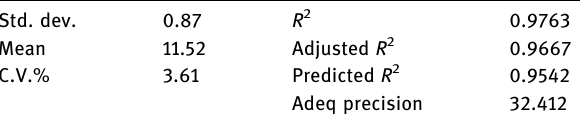
Table 18: Fit statistics for adhesion